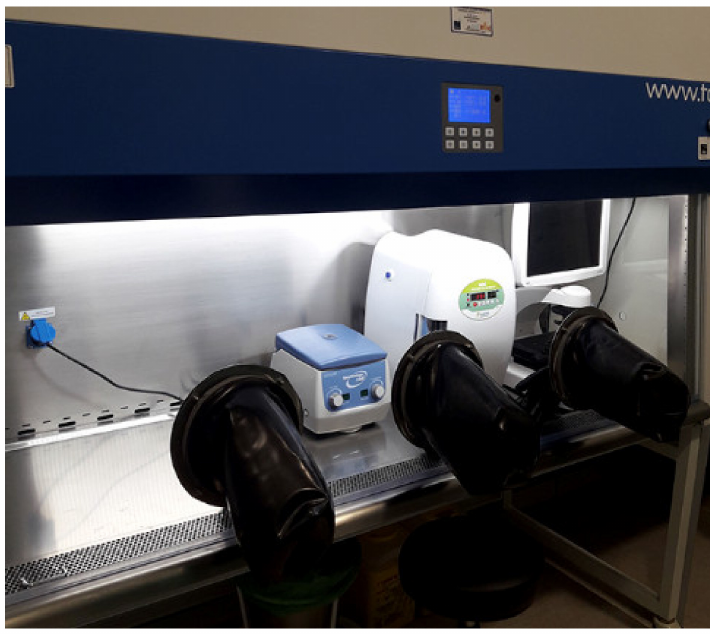
Figure 2. Mini cleanroom.